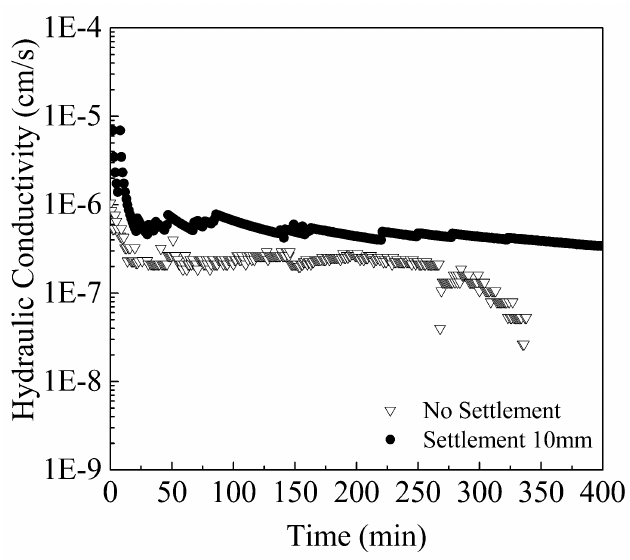
Figure 7. Time and hydraulic conductivity (soil thickness100 mm; without geogrid).